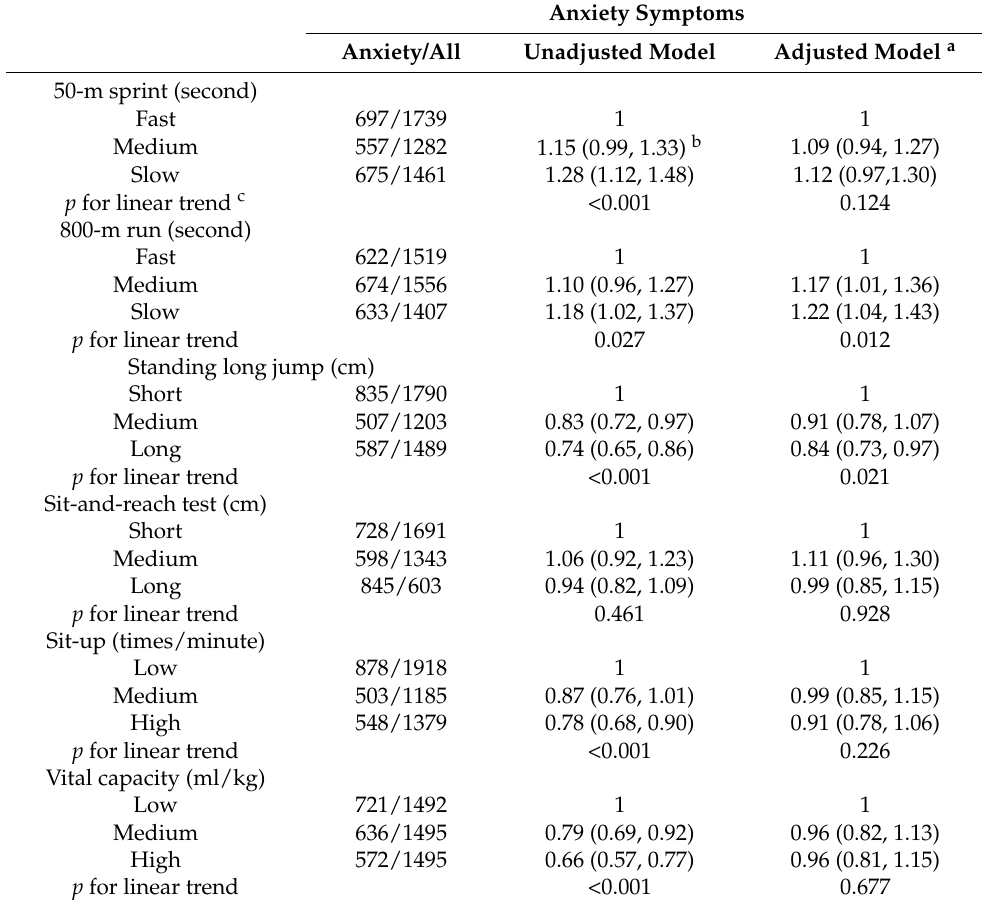
Table 4. Adjusted relationship between physical fitness and anxiety symptoms in 4482